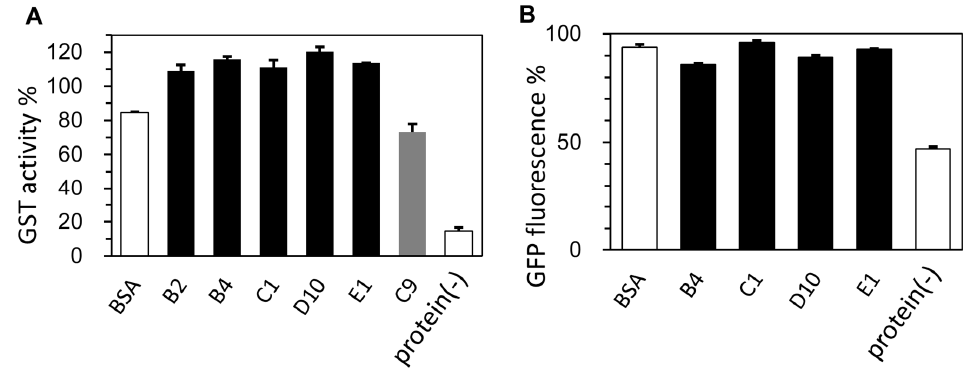
Figure 4. Cryoprotective activity of human genome-derived IDPs and control proteins towards glutathione S -transferase (GST) and enhanced green fluorescent protein (EGFP). ( A ) GST activities (final concentration of 11 μ g/mL) after freeze-thawing in the presence of 500 μ g/mL indicated additive protein. GST activity of the untreated sample was set to 100%; ( B ) EGFP fluorescence (final concentration of 65 μ g/mL) after freeze-thawing in the presence of 500 μ g/mL indicated additive protein. The EGFP fluorescence of the untreated sample was set to 100%. Error bars indicate the standard deviation of triplicate measurements. IDPs and “partial” IDPs are colored as black and gray, respectively. Protein (-) indicates LDH activity without cryoprotectant.